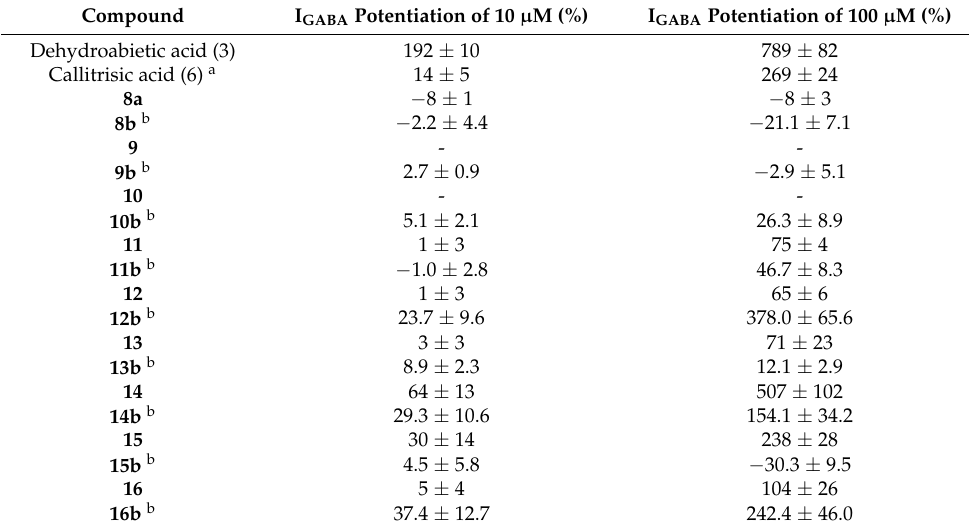
Table 5. Potentiation of I GABA in α 1 β 2 γ 2S receptors by compounds 8a, and 9–16. Compound I GABA Potentiation of 10 µ M